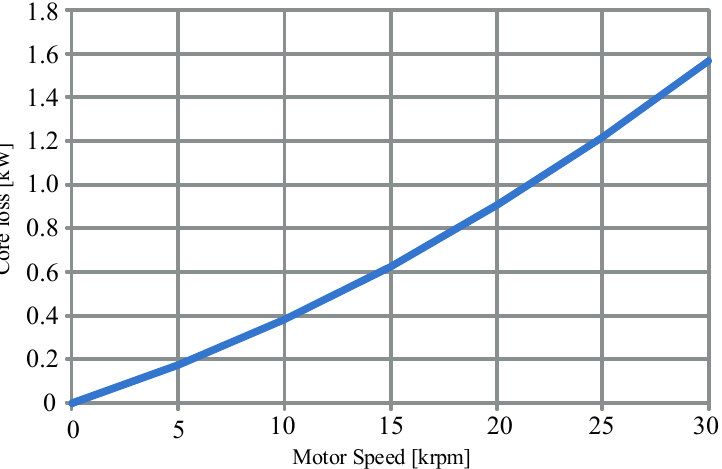
Figure 17. Core loss vs. speed change graph. Table 5. Core loss and speed change.